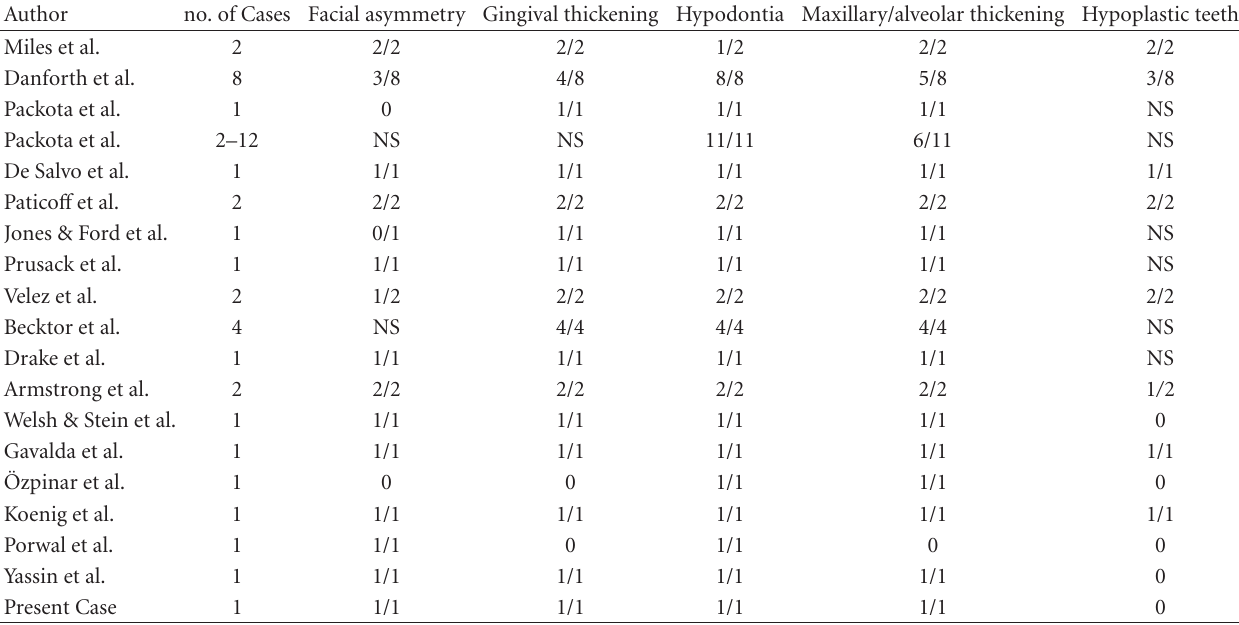
Table 1: Clinical features of 43 patients with segmental odontodysplasia.